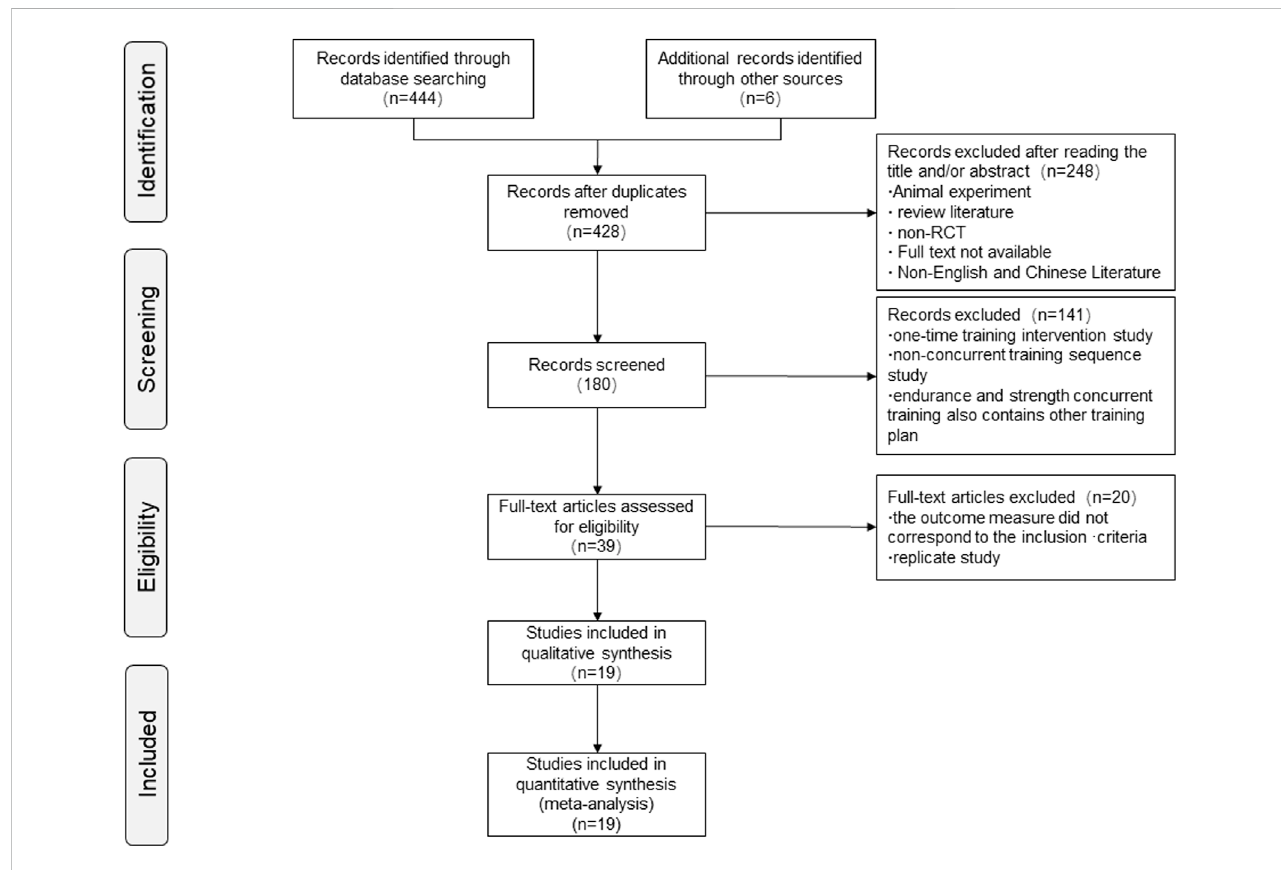
FIGURE 1 Flowchart of studies